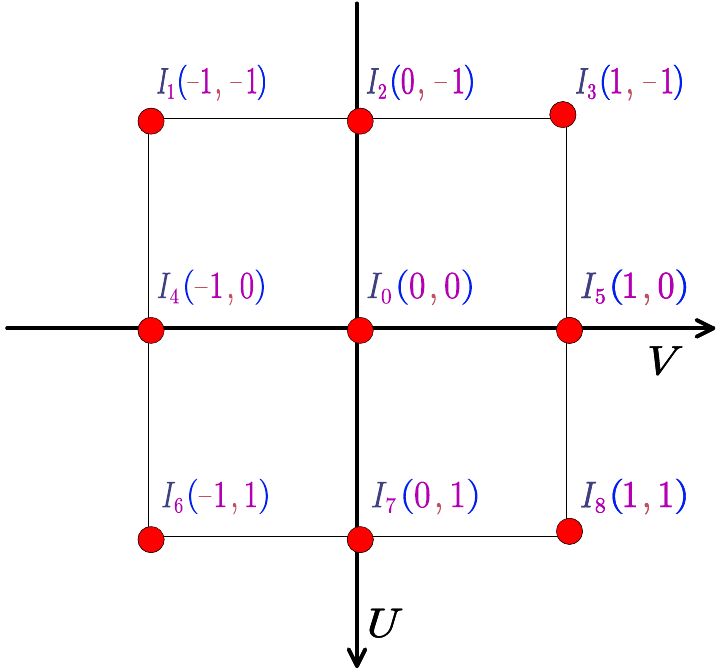
Figure 6. Quadratic surface fitting coordinate